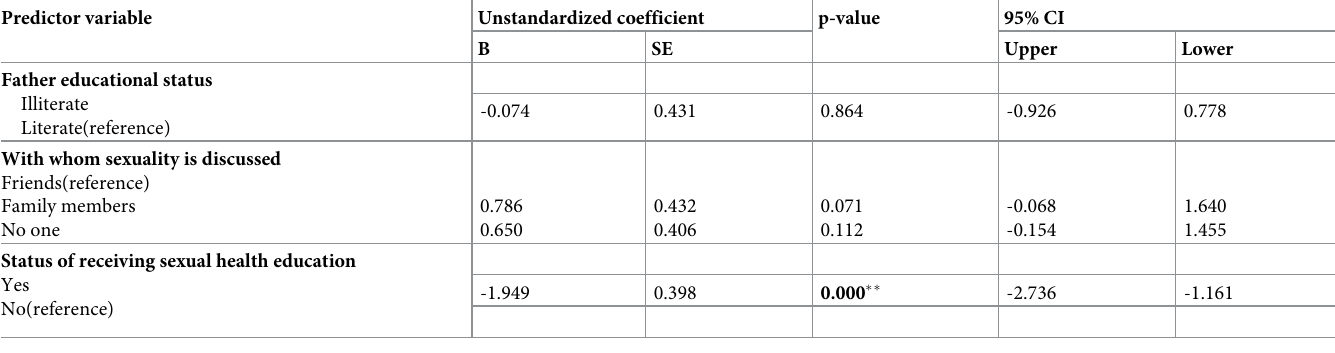
Table 4. Multivariable linear regression analysis regarding sexual healthcare among nursing students (n = 134). Predictor